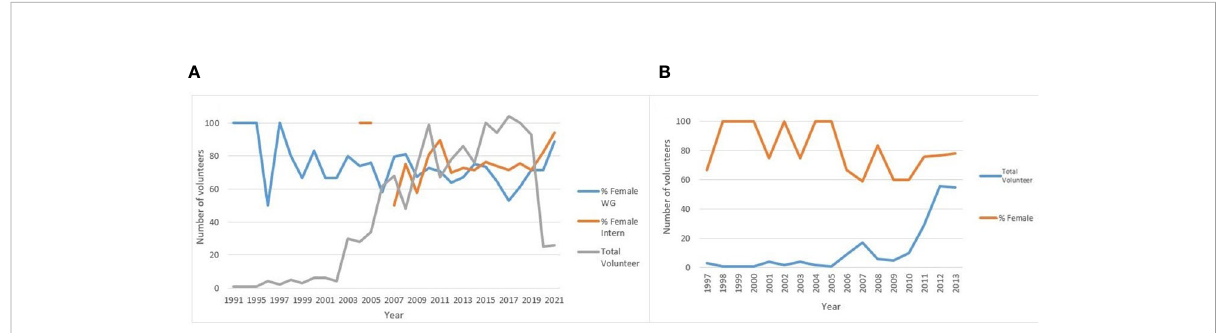
FIGURE 1 Percentage of women ’ s involvement with CCF ’ s (A) intern and working guest (WG) volunteer programs and (B) Earthwatch volunteer program with total representing the total number of volunteers per year.